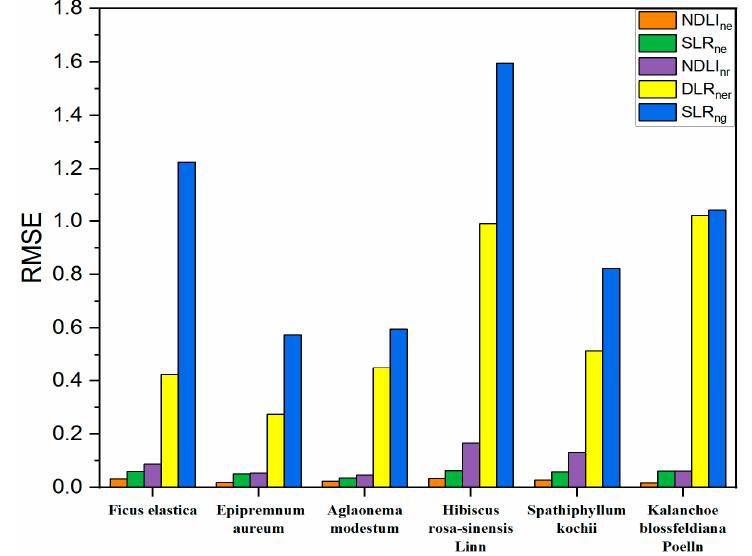
Figure 13. The RMSE deviation results of the laser ratio indices of the leaf samples.